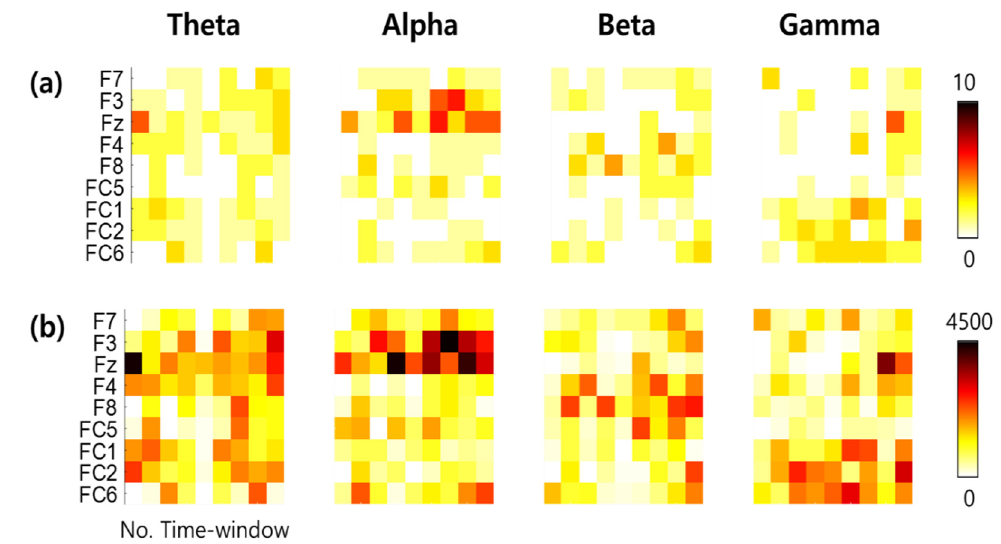
Figure 9. Frequencies of selected features by least absolute shrinkage and selection operator (LASSO). ( a ) The sum of participants out of 23 for the features that were selected by LASSO for more than 50% of trials. The darker colored feature represents that it was used for decoding anxiety by more participants. ( b ) The sum of training sets out of 17,775 for the features that were selected by LASSO.